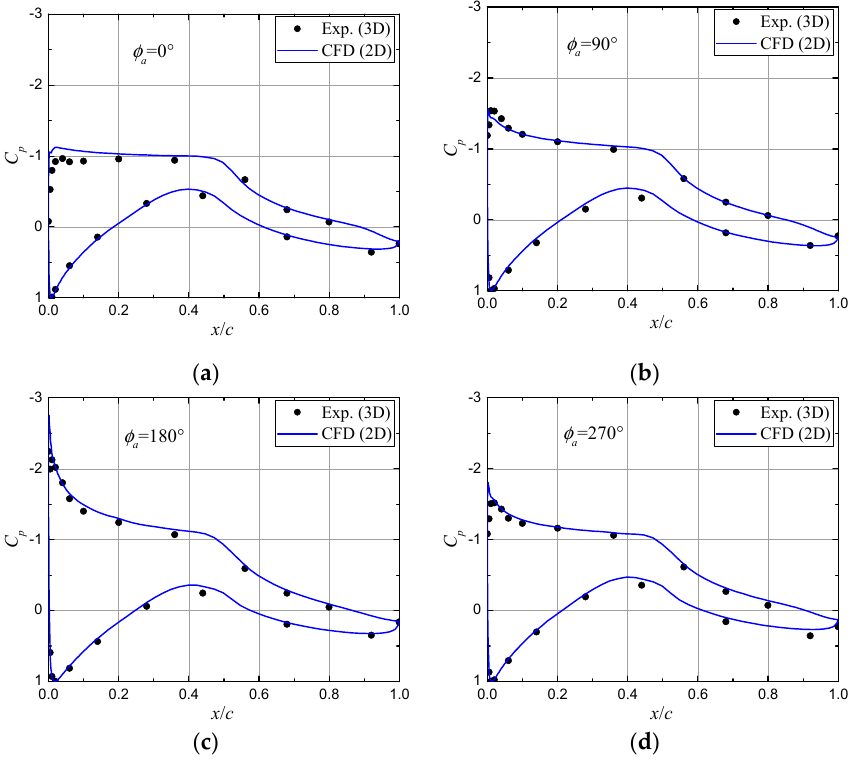
Figure 7. Unsteady pressure distributions of the 63% span on the NREL Phase VI rotor at di ff erent azimuths. V w = 7 m / s and φ y = 30 ◦ (S0700300). ( a ) φ a = 0 ◦ ; ( b ) φ a = 90 ◦ ; ( c ) φ a = 180 ◦ ( d ) φ a = 270 ◦